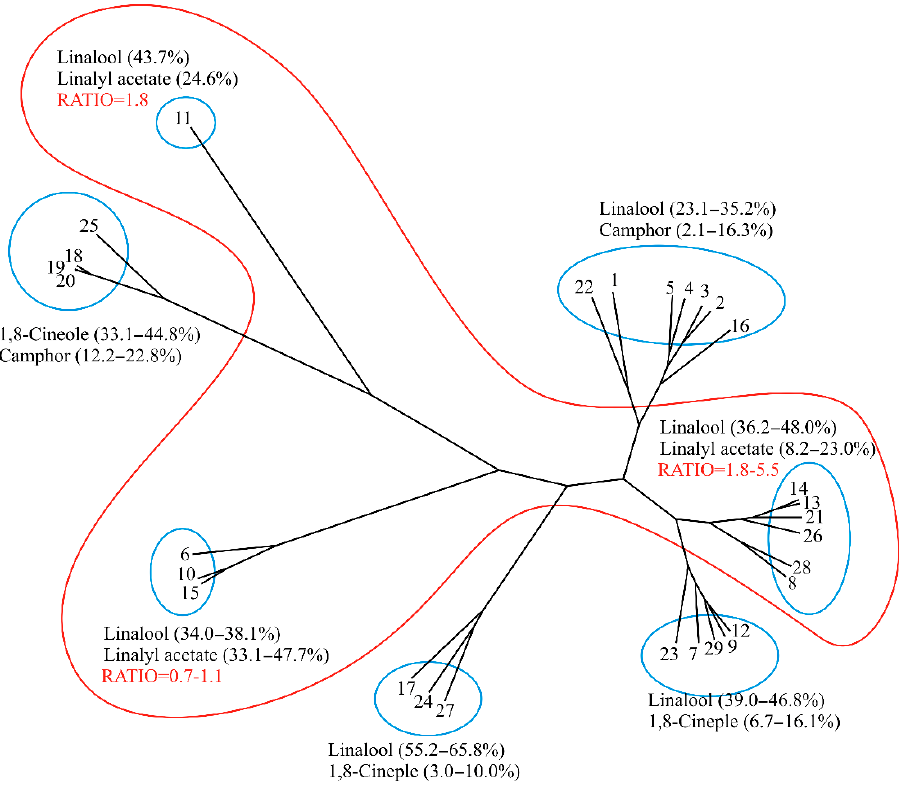
Figure 5. Unrooted cluster tree for chemical composition of L. x intermedia essential oil (samples are coded according to Table 6. coded according to Table